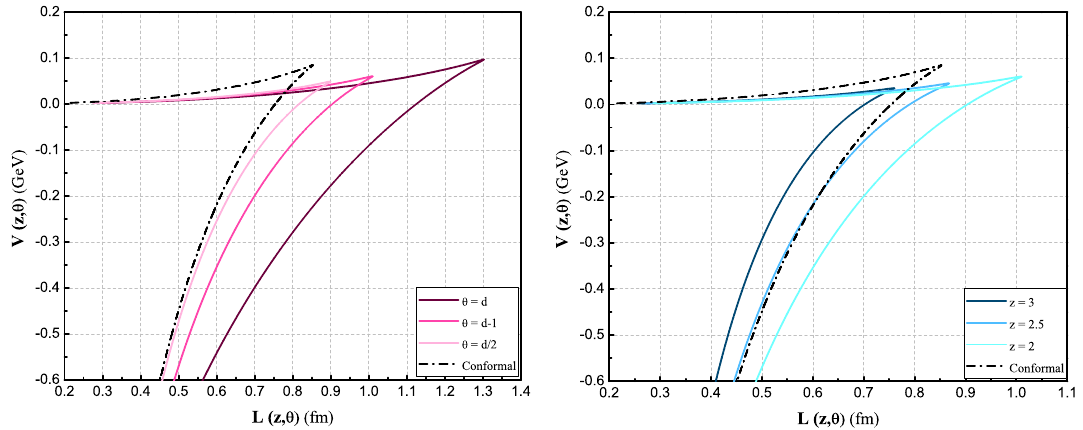
Fig. 1 Left: the heavy quark potential versus the quark-antiquark separation in different θ at z = 2 and Q = 1. Right: the heavy quark potential versus the quark-antiquark separation in different z at θ = d − 1 and Q =